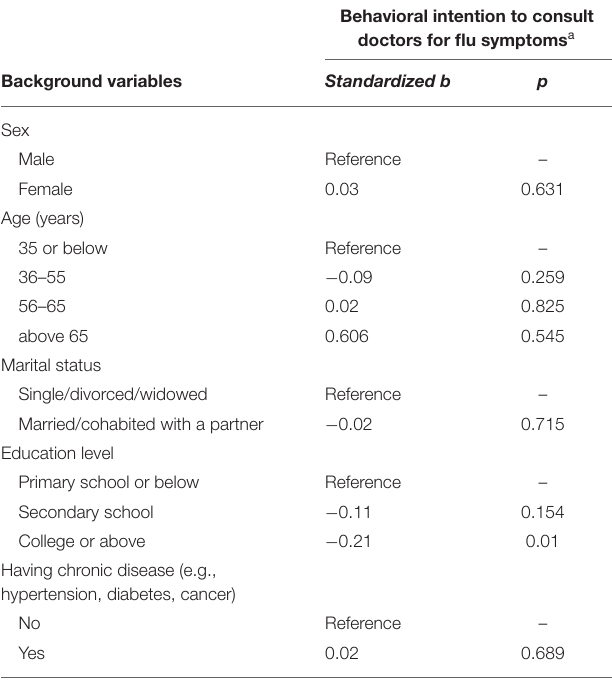
TABLE 2 | Associations between background variables and the behavioral intention to consult doctors for flu symptoms ( N =